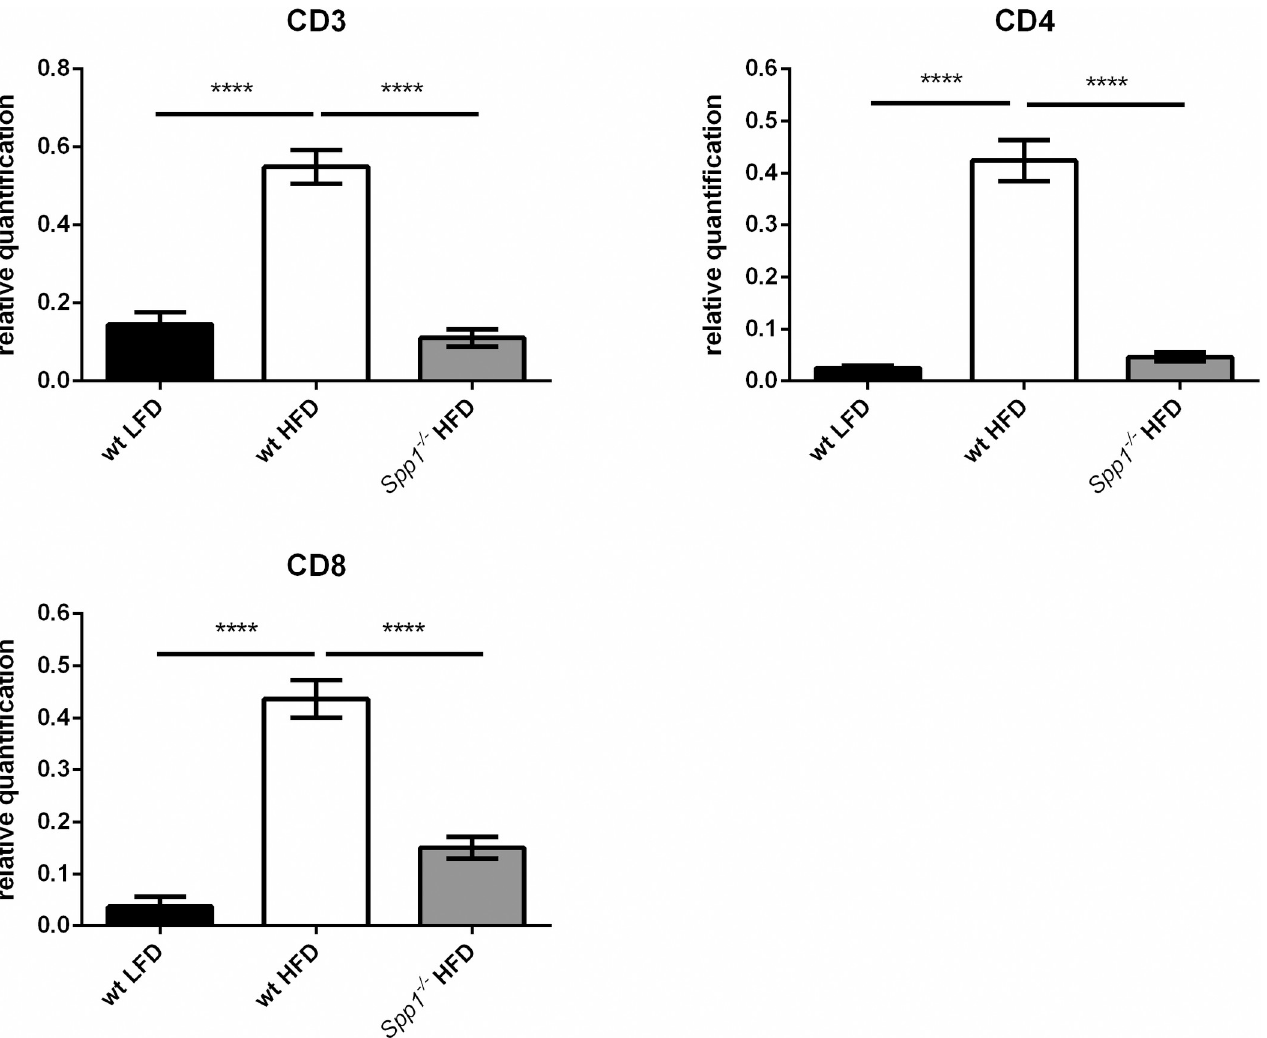
Fig 2. Relative amount of T cells in adipose tissue. The CD3, CD4 and CD8 immunofluorescence intensity in gonadal fat was measured and divided by the number of nuclei (stained with DAPI) resulting in a relative quantification. 2–5 pictures were taken per mouse, 4–5 mice were analyzed. Comparison of groups with wt HFD group; ���� p <